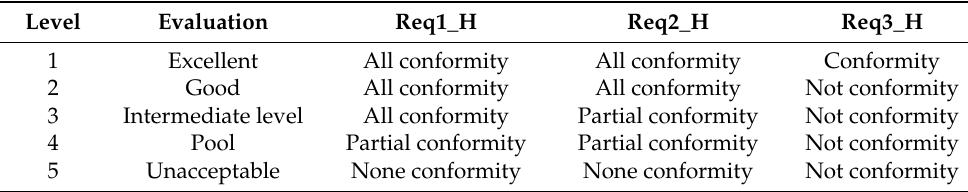
Table 5. Subjective evaluation criteria of brushing